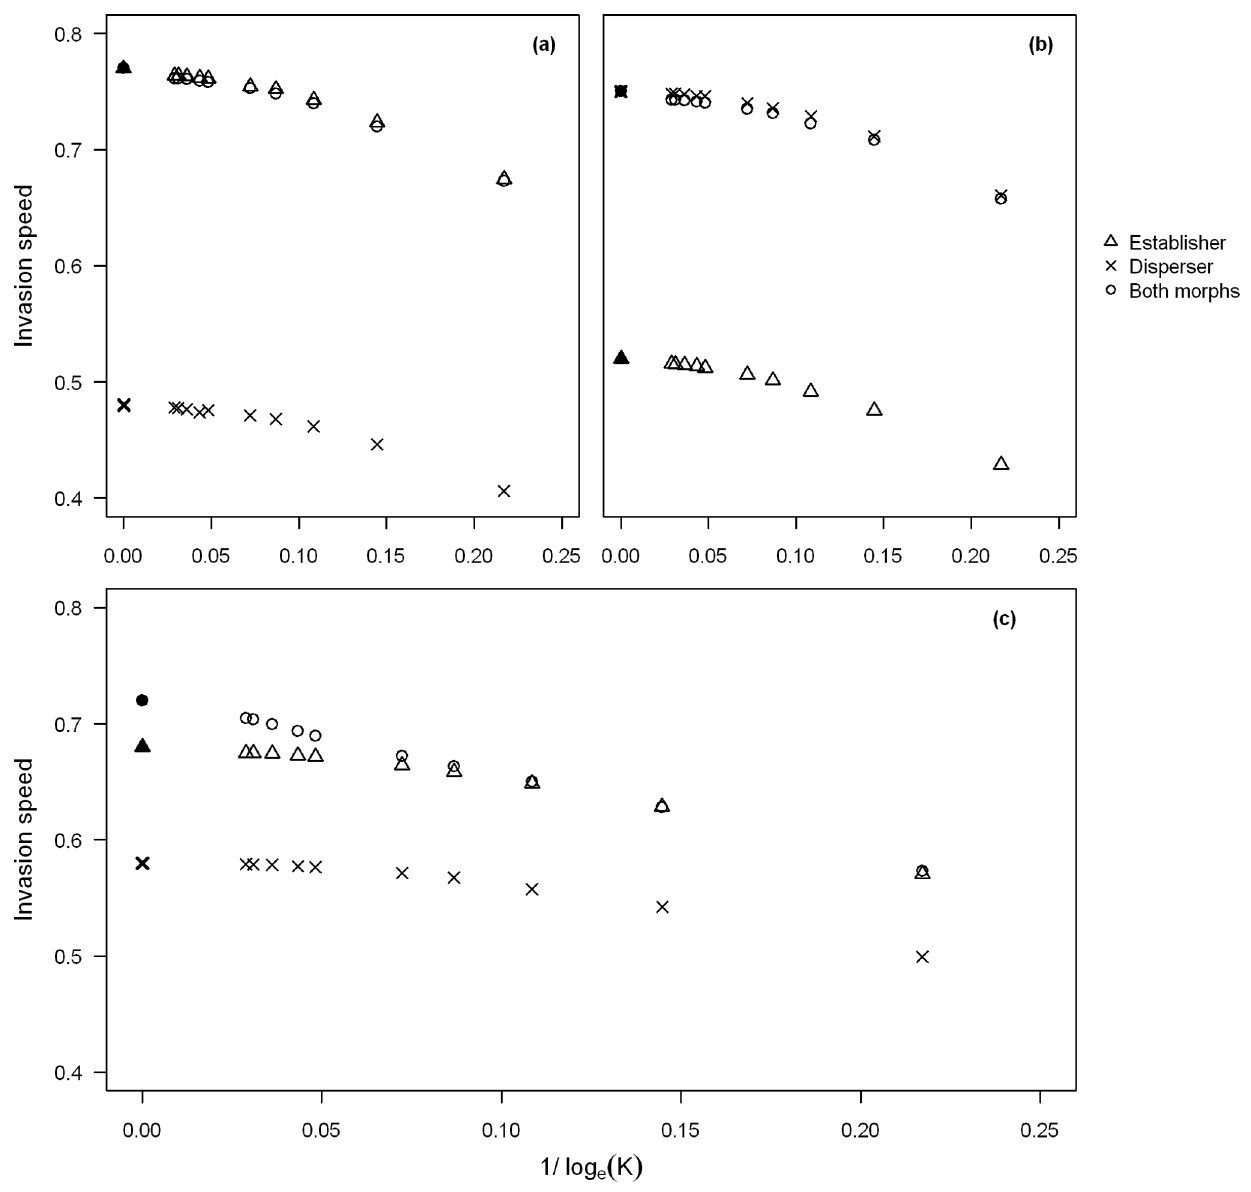
Figure 3. Comparison of stochastic and deterministic invasion speeds at different carrying capacities. The filled symbols represent the deterministic prediction and the empty symbols the stochastic predictions. The triangles represents the establisher morphs speed, the crosses the disperser morphs speed and the circles the invasion speed when both morphs are present. In (a) the polymorphic invasion speed is the same as the monomorphic establisher speed; in (b) the polymorphic invasion speed is the same as the monomorphic disperser speed, and in (c) the polymorphic invasion speed is faster than either monomorphic invasion. Parameter values used in (a) and (b) are the same as in Fig. 1 (a) and (b) and in (c) the parameter values used were r e ~ 1 , r d ~ 0 : 2 , D d ~ 0 : 9 , D e ~ 0 : 2 , m ~ 0 : 01 , with K ranging from K ~ 100 to K ~ 10 14